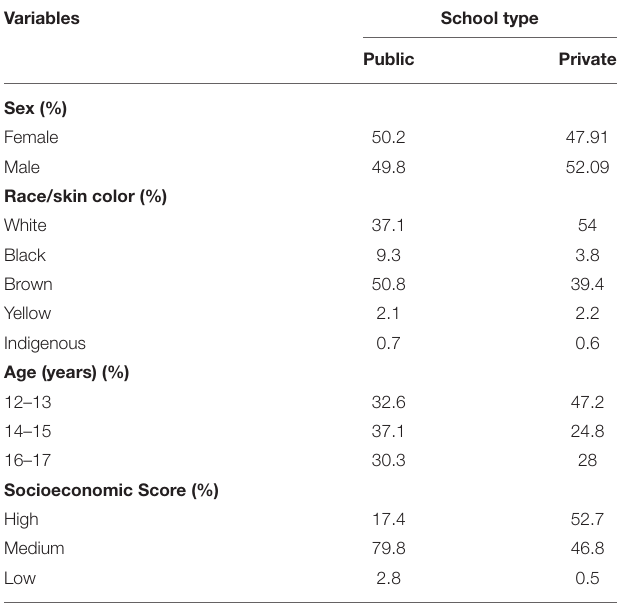
TABLE 1 | Characterization of Brazilian adolescents evaluated by the ERICA study, Brazil (2013–2014; n = 71,549).